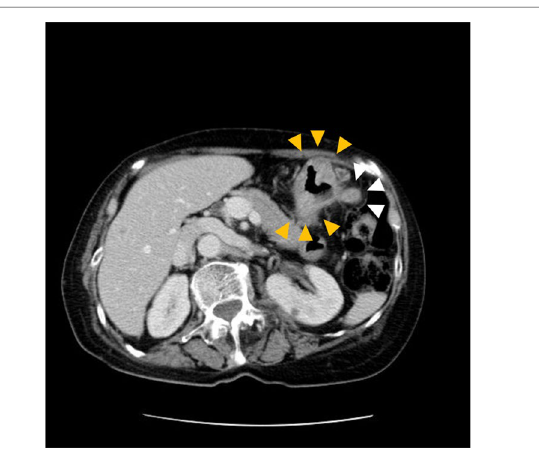
Fig. 3 Abdominal CT. There is irregular wall thickening with a contrast effect on the posterior wall of the lower stomach (yellow arrow). Multiple enlarged lymph nodes are observed on the greater curvature of the stomach (white arrow). No obvious distant metastasis is